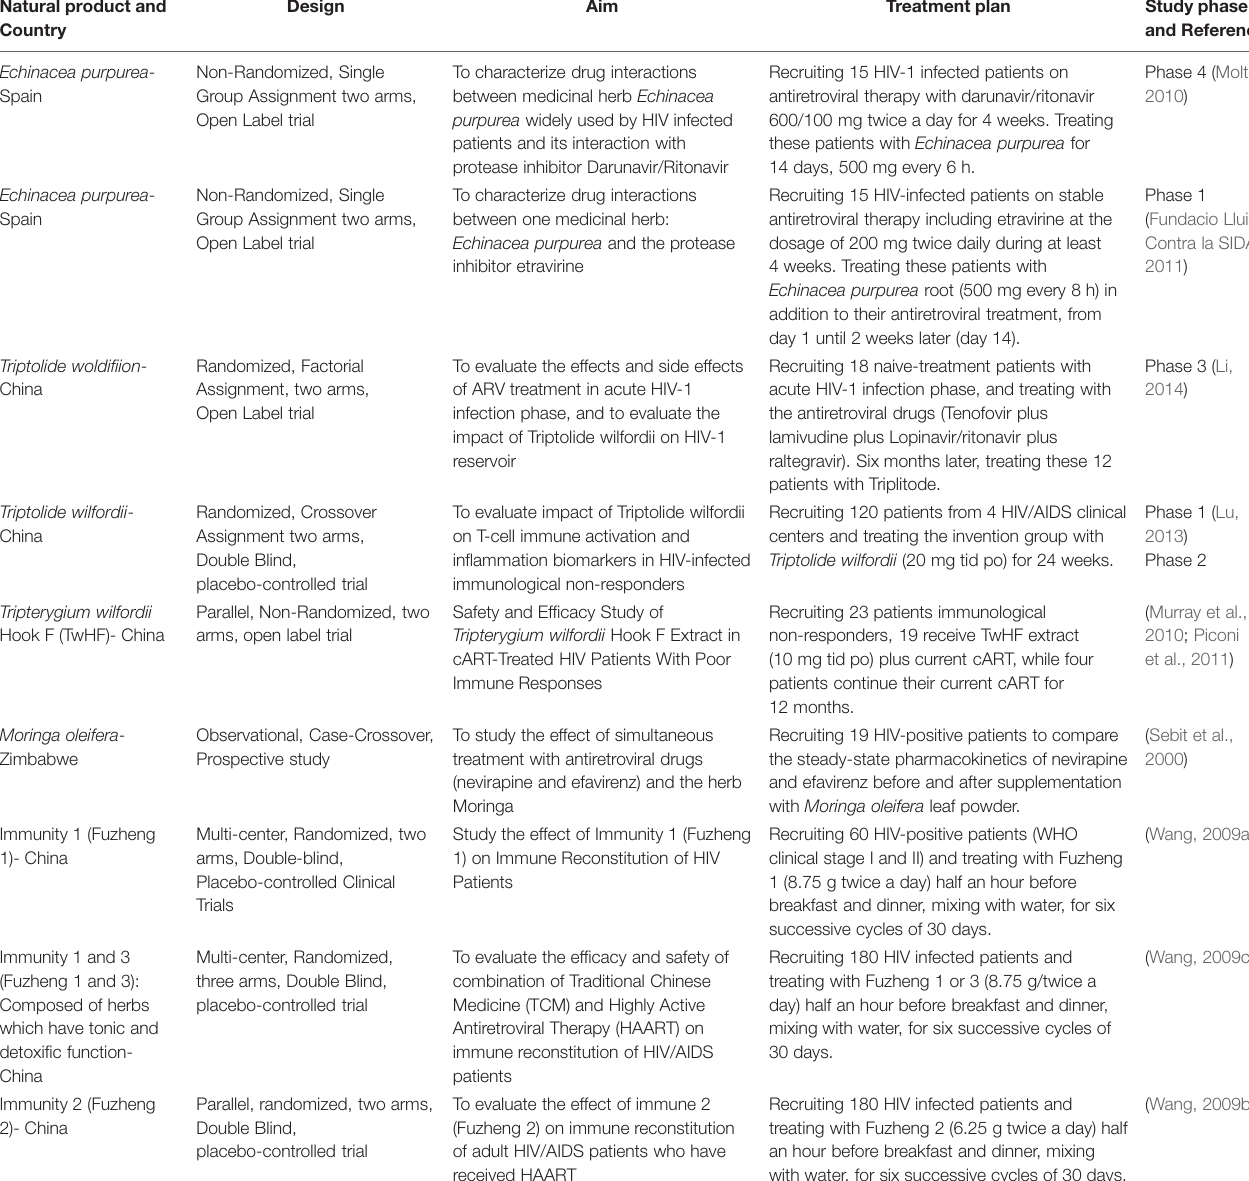
TABLE 1 | Summary of clinical trials of natural products for treating HIV and